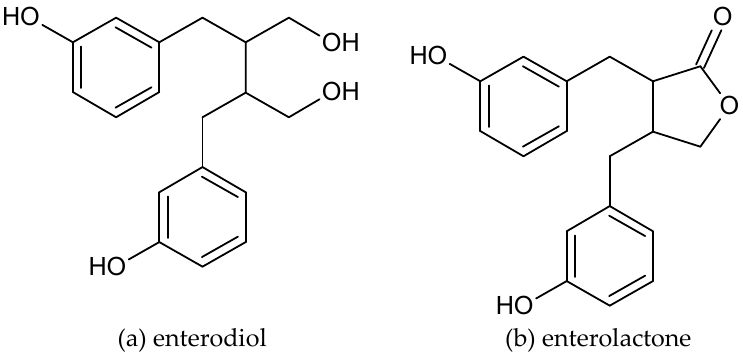
Figure 2. The chemical structure of enterolignans, ( a ) enterodiol and ( b ) enterolactone.